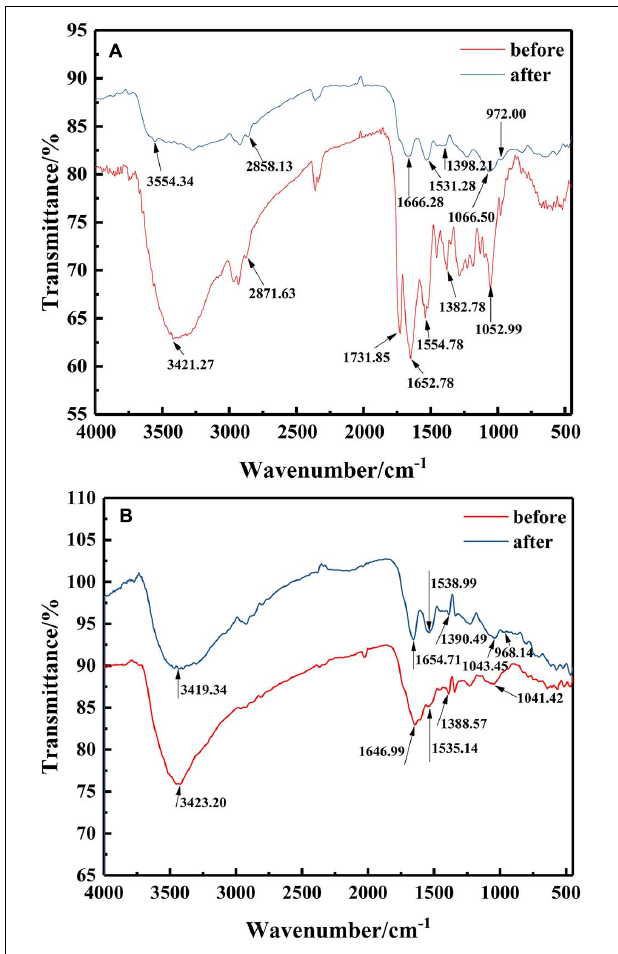
FIGURE 4 | FTIR spectra of the mineralized products by (A) ZJ-1 and (B) ZJ-3 before and after U treatment (initial concentration, 50 mg L − 1 of U at pH 7.0; time 7 days; temperature, 30 ◦